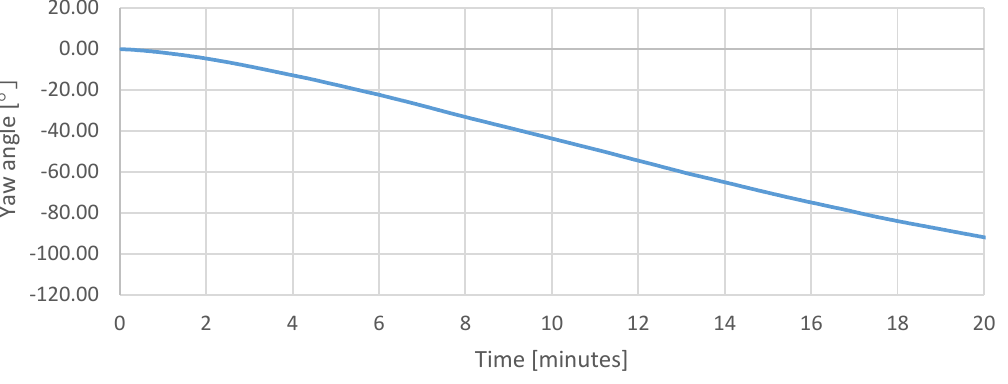
Figure 20. Stationary measurements of estimated yaw